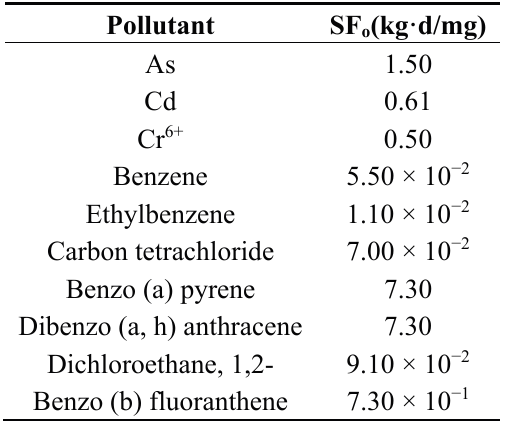
Table A1. Carcinogenic slope factor (SF o ) of carcinogenic pollutants (From the Technical Guidelines for Risk Assessment of Contaminated Sites HJ 25.3-2014 ).